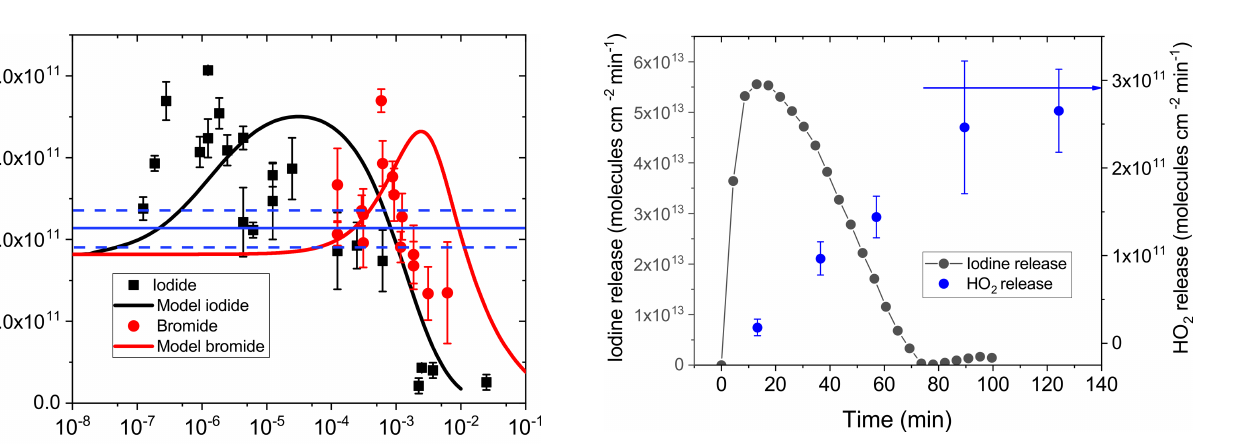
Figure 3. Iodine release calculated from the measured mass size distribution of iodine oxide particles produced by the oxidation of iodine species released from the CWFT. The left y axis is expressed as equivalent I 2 release (gray circles), and the right y axis is the corresponding HO 2 release (blue circles) into the gas phase versus time while irradiating a film in the CWFT loaded with 2.5mg of IC, 76.8mg of CA and 313µg of NaI and equilibrated at 34% RH (33mMI − ). The blue arrow indicates the HO 2 release expected for the film in the absence of